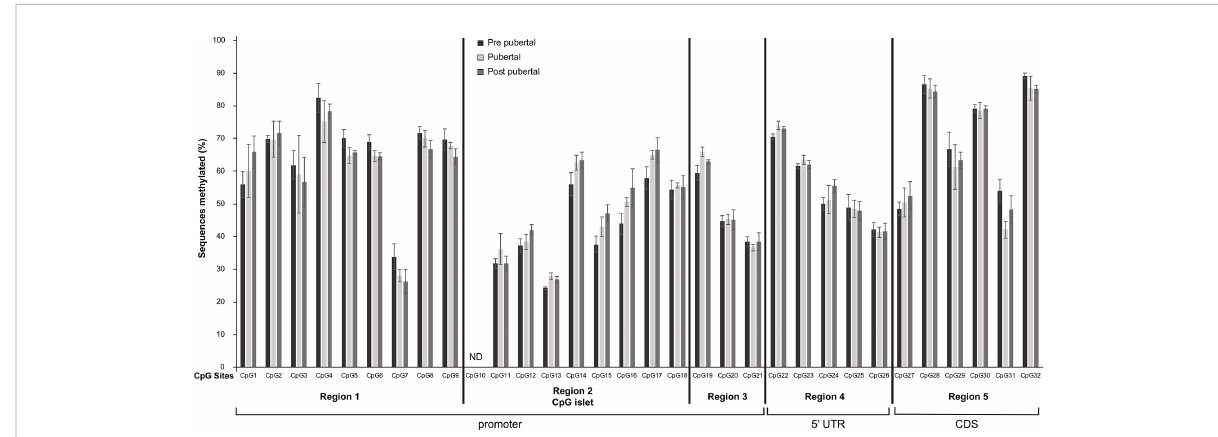
FIGURE 2 Differential methylation of CpG dinucleotides located in the promoter, 5 ’ UTR and the fi rst 50 nucleotides of the coding region of Mkrn3 gene. Bar graphs showing the percentage of methylated CpGs in hypothalamus at pre-pubertal, pubertal and post-pubertal developmental stages. The fi ve grouped regions are depicted with black vertical lines. CDS, Coding DNA Sequence; ND, no